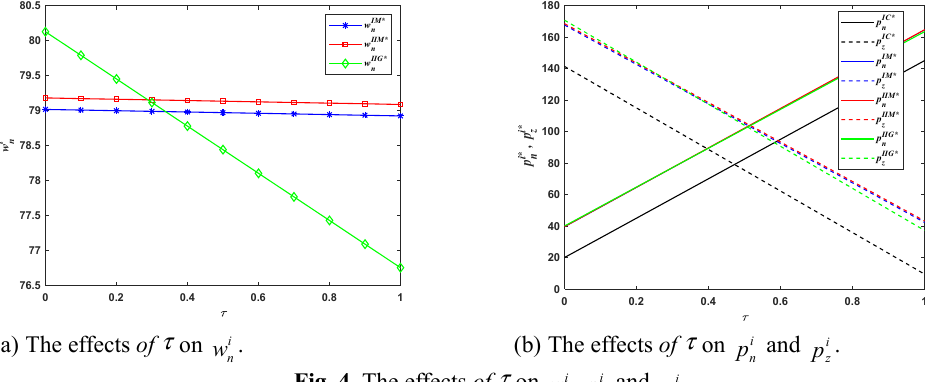
Fig. 4. The effects of τ on